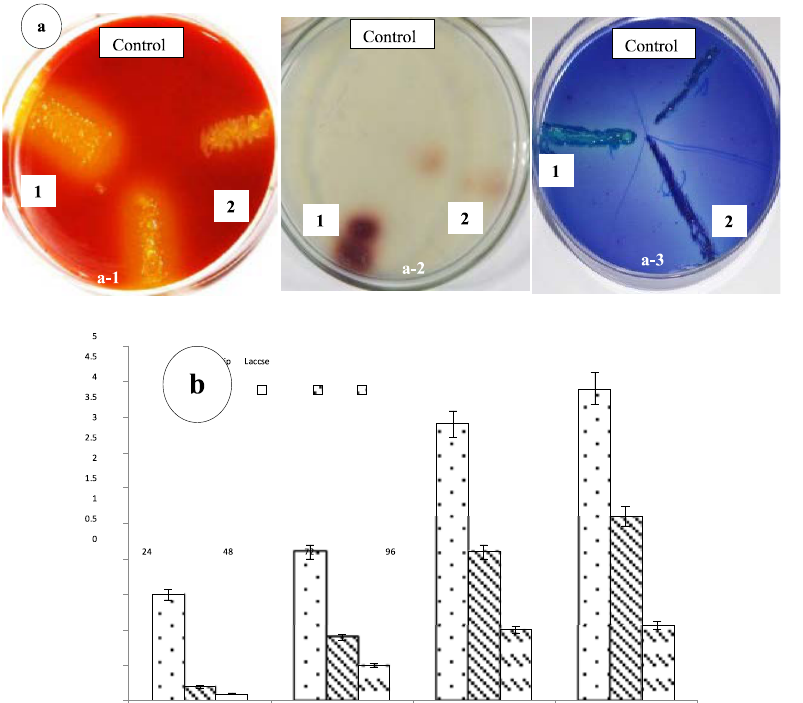
Fig. 5. The ligninolytic i.e. a-1 (Mnp), a-2 (Lip) and a-3 (Laccase) enzyme activity isolated bacterial strains a ( Aeromonas salmonicida ) and b ( Bacillus sp) on plate assay (a) and for the extracellular enzyme activity was measure by biostimulated sample (b).